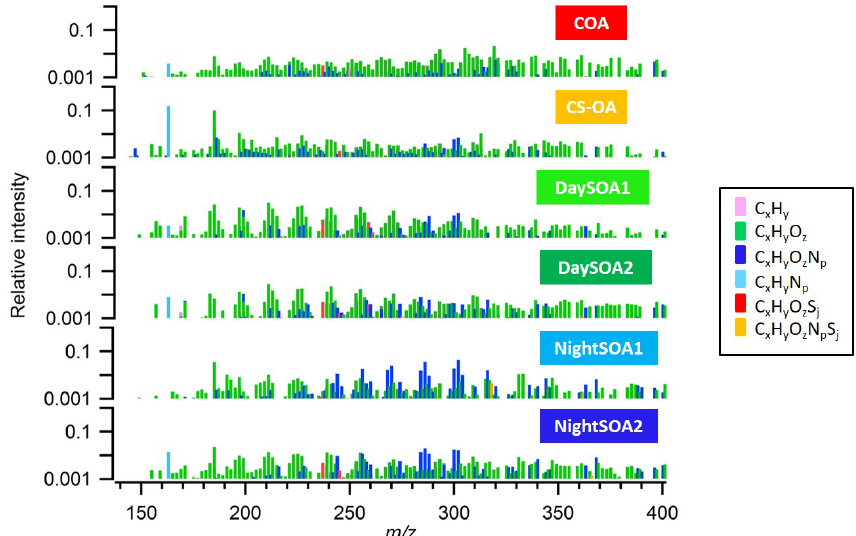
Figure 2. Mass spectra in log scale of the six identified OA EESI-TOF-MS PMF factors, colour-coded according to their chemical families. The sum of each spectrum is normalized to 1.